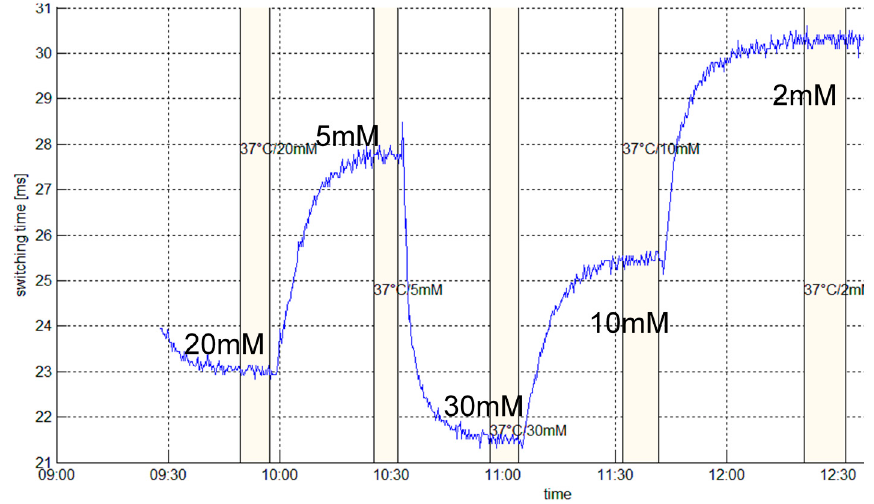
Figure 4. Calibration measurement for determining the switching time t sw in dependence of glucose concentrations c g , i.e., 20, 5, 30, 10, and 2 mM of glucose, respectively, in standard